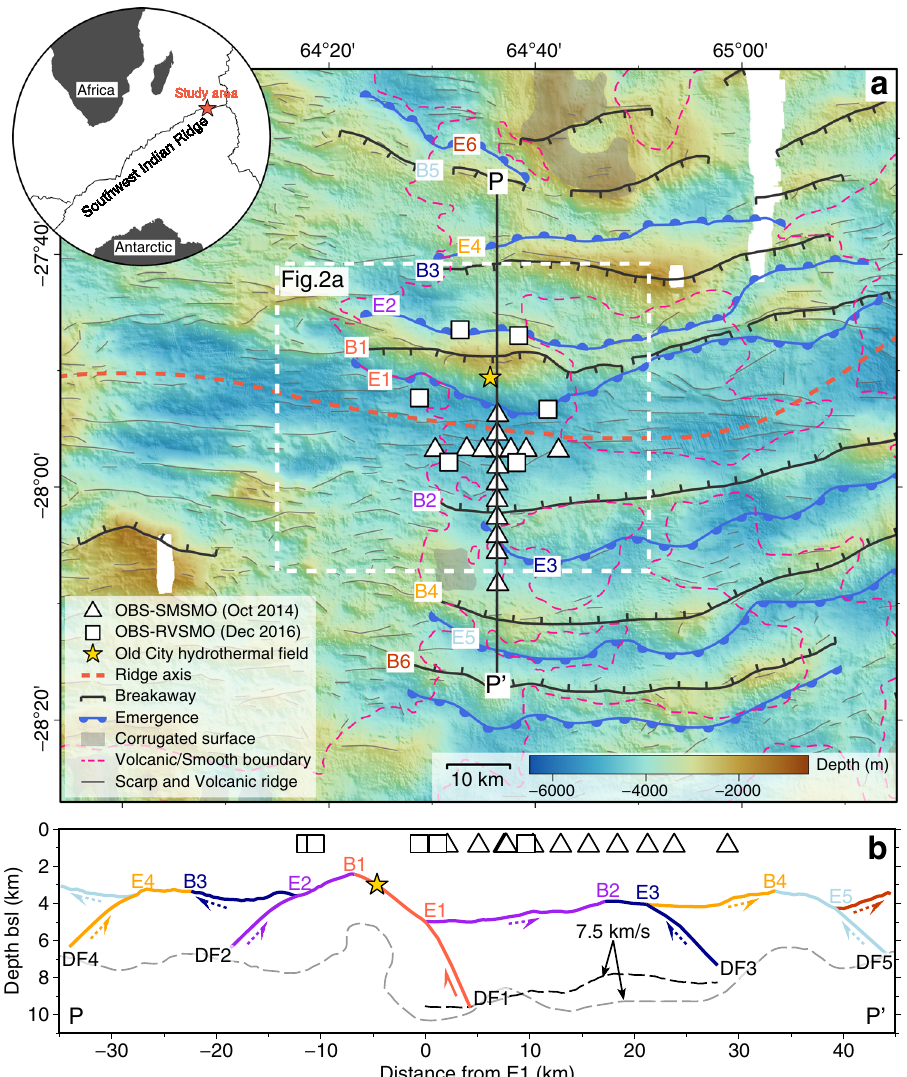
Fig. 1 | OBS locations and tectonic interpretation of the fl ip- fl op detachment fault system at the eastern SWIR. a Tectonic map with locations of the OBS networks: SMSMO (14 OBSs) and RVSMO (6 OBSs). The base map is created based on shipborne bathymetry data 4 . Geological and tectonic information (see legend for symbols) includes breakaways (B1 – B6) and emergences (E1 – E6) of successive detachmentfaults,corrugatedsurface,theboundarybetweenvolcanicandsmooth sea fl oor, and linear sketches of scarps and volcanic ridges 1 . Yellow star is the low-